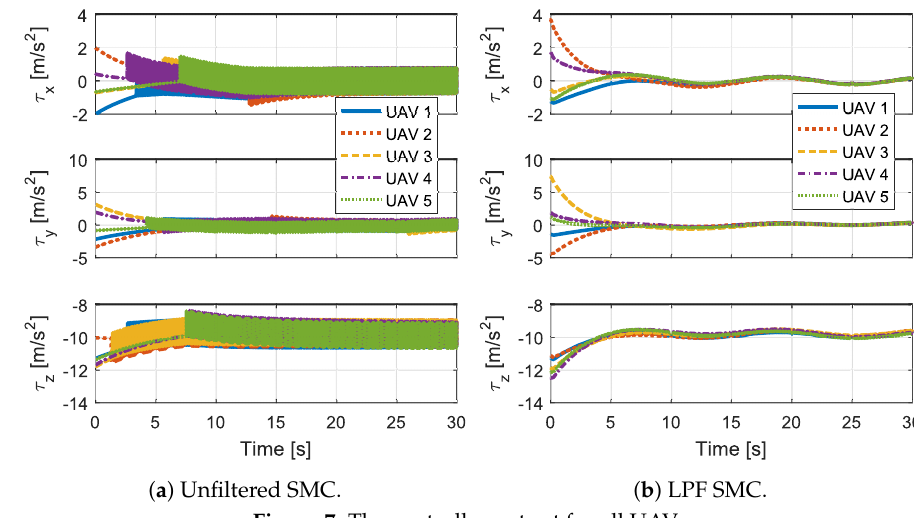
Figure 7. The controller output for all